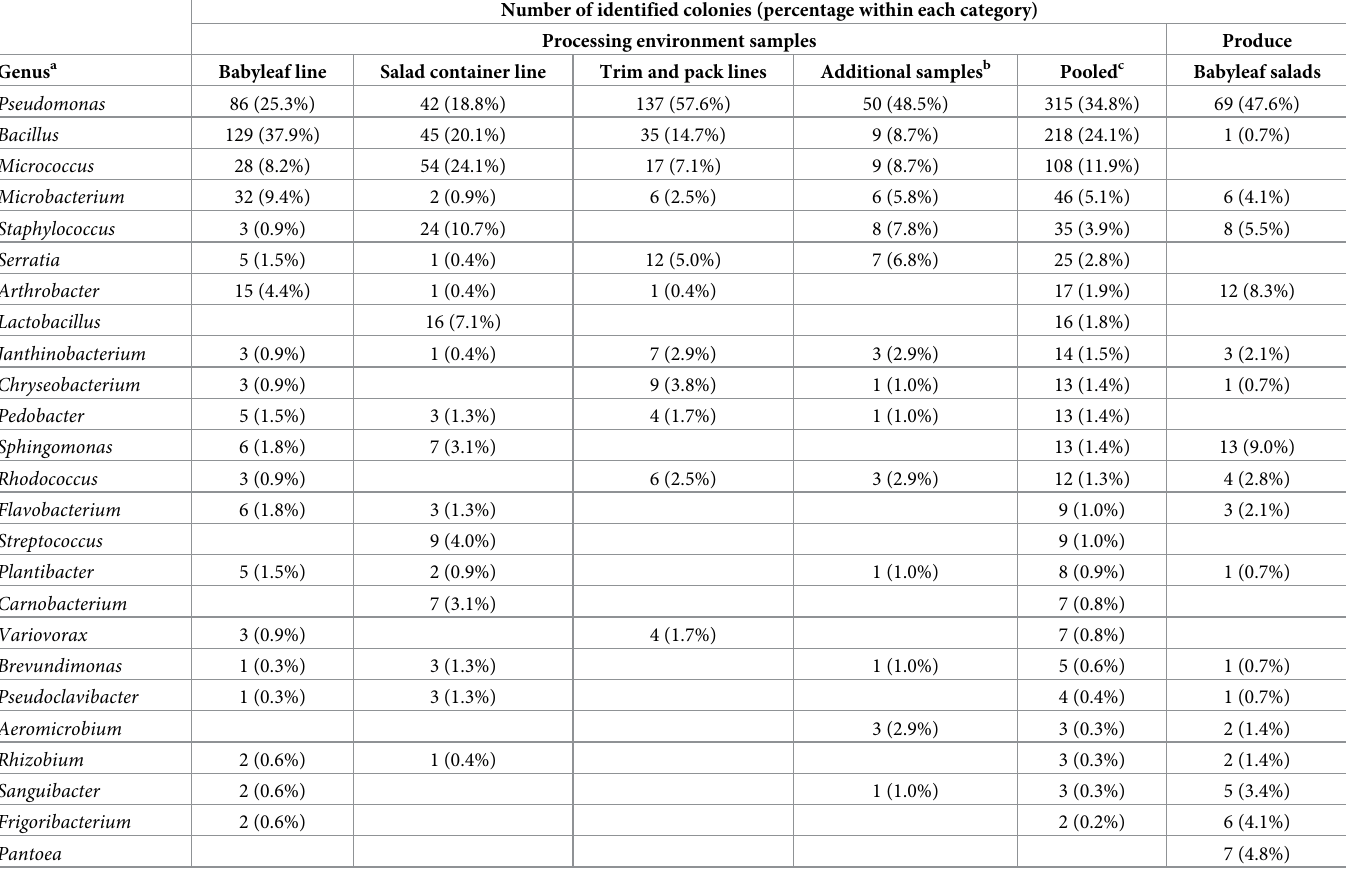
Table 1. Microbiota in fresh produce processing plant.